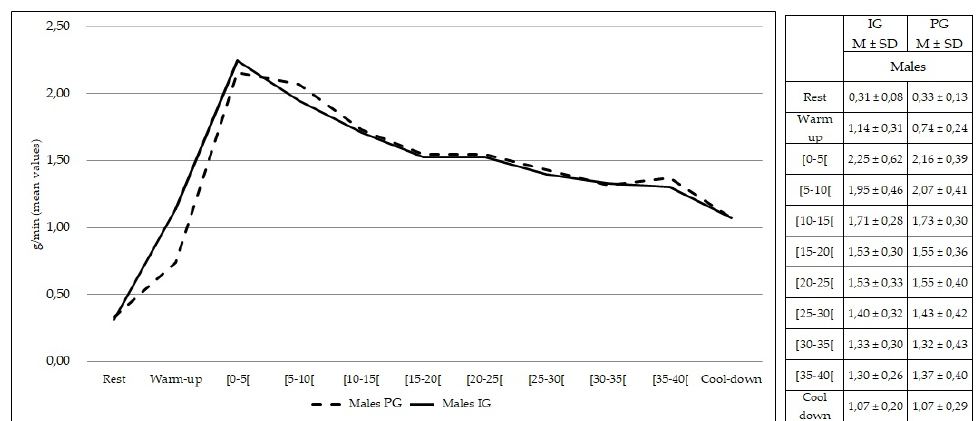
Figure 9. Carbohydrate oxidation during rest, exercise, and cool-down in males (intervention group vs. placebo group). Data are expressed as mean ± standard deviation. IG: intervention group; PG: placebo group.